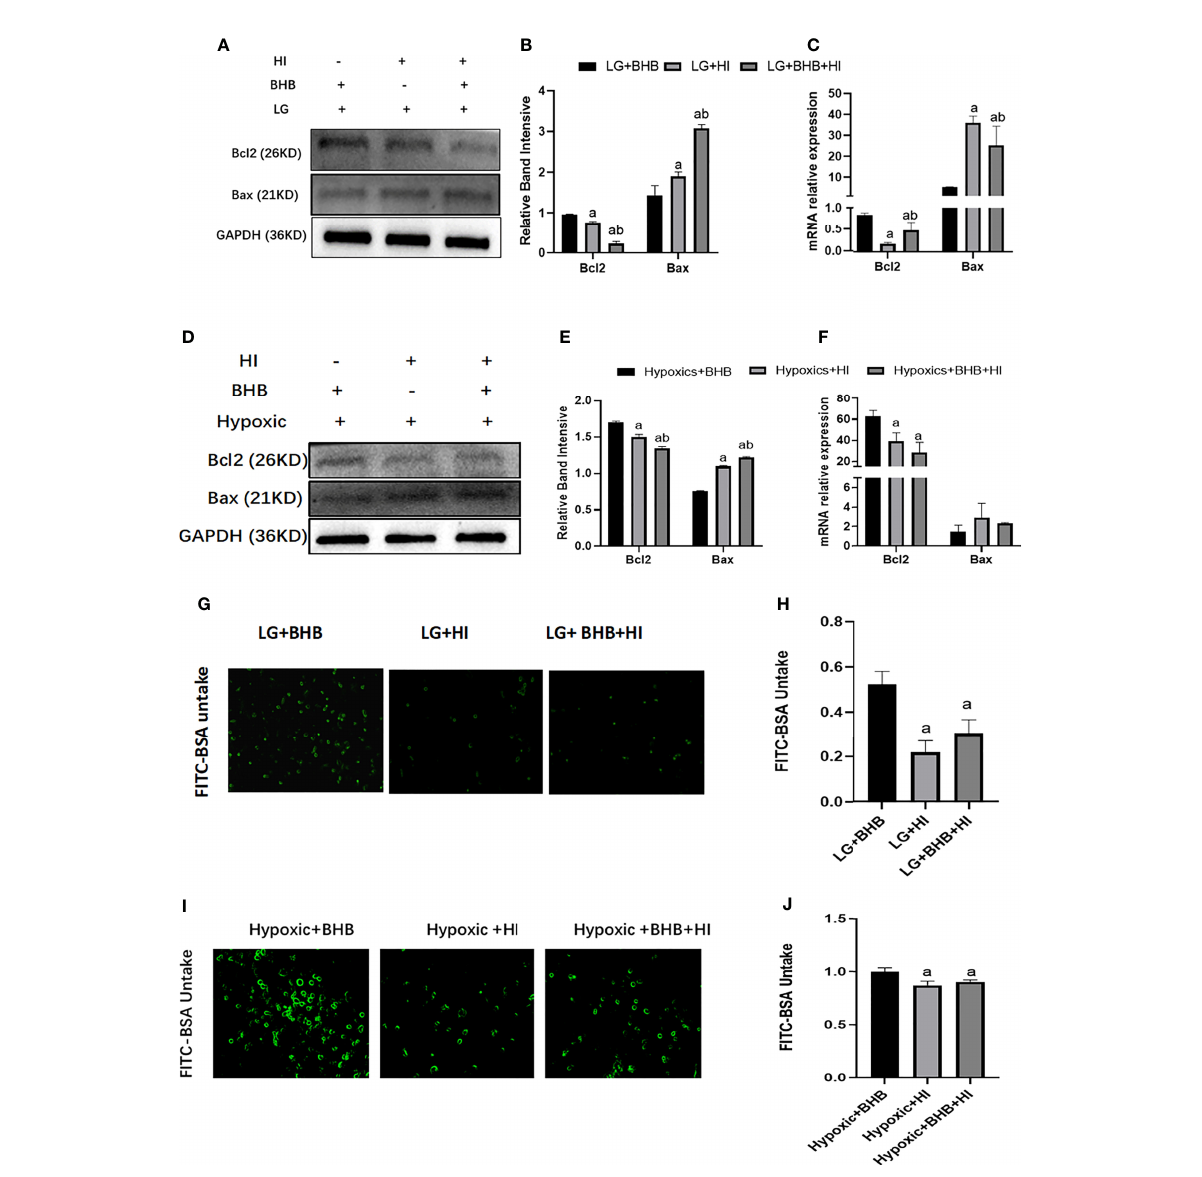
FIGURE 10 Effect of high insulin on BHB induced protection on apoptosis and endocytic albumin in HK2 cells under low glucose or hypoxic conditions. (A, D) Expression of Bcl-2 and Bax; (B, E) Quantitative results of Bcl-2 and Bax proteins; (C, F) Quantitative results of Bcl-2 and Bax gene expression; (G, I) Changes of endocytic albumin detected by fl uorescence microscopy; (H, J) Changes of endocytic albumin detected by a microplate reader. In panels (B, C, H) a p < 0.05, compared with the LG+BHB group; b p < 0.05, compared with the LG+HI group; in panels (E, F, J) a p < 0.05, compared with the Hypoxic + BHB group; b p < 0.05, compared with the Hypoxic + HI